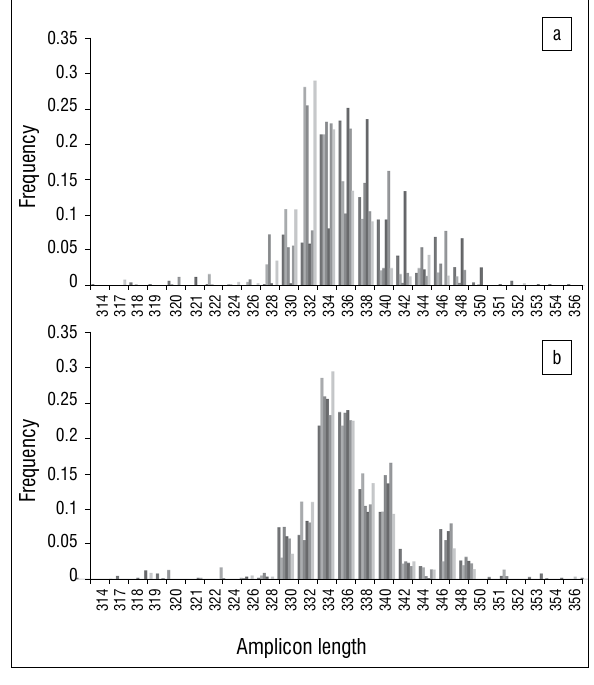
The population frequencies for AVPR1A alleles when (a) expected amplicon differences caused by primer differences are taken into account and (b) allele sizes are adjusted so that allele-frequency spectra of populations correspond best with each other. The data are drawn from Table